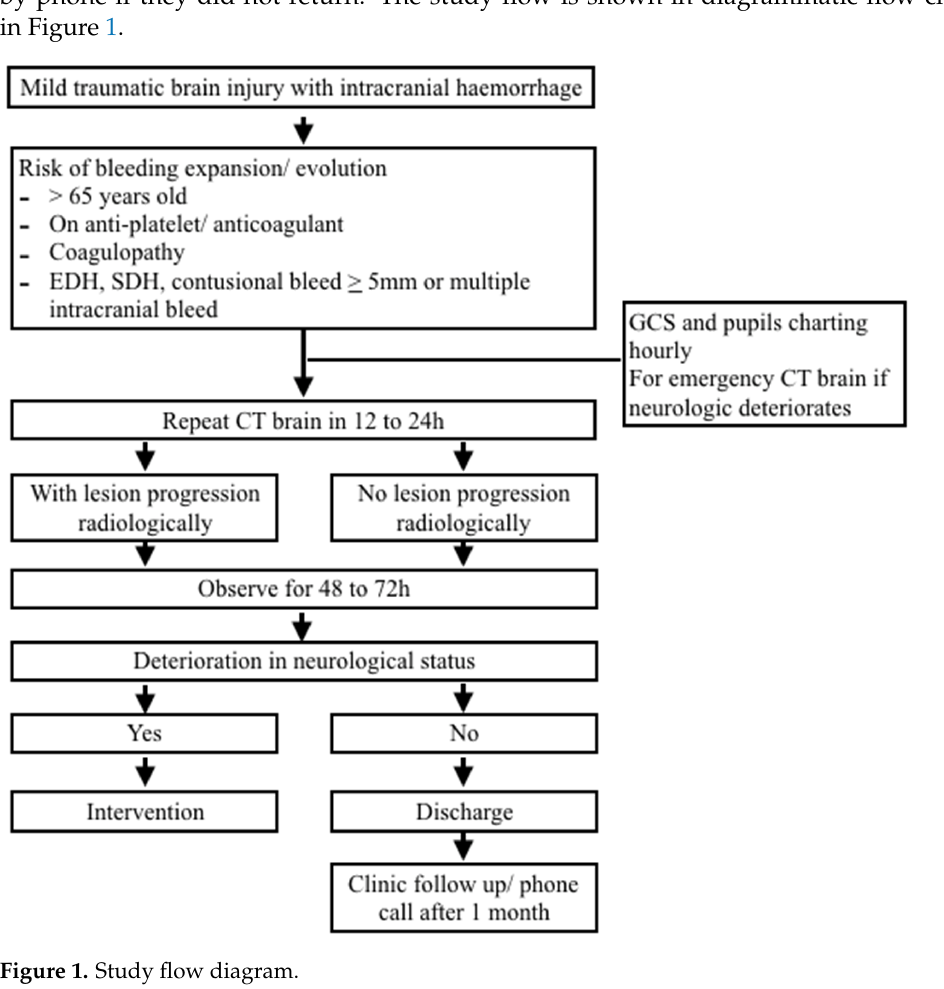
Figure 1. Study flow diagram.